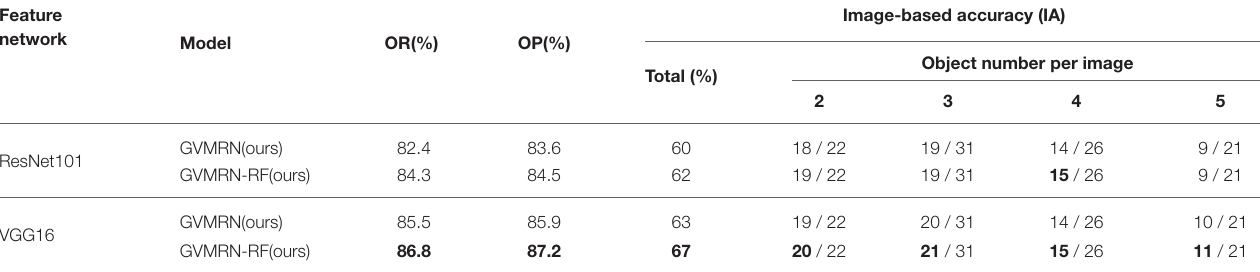
TABLE 3 | Results of visual manipulation relationship reasoning in robot experiment.